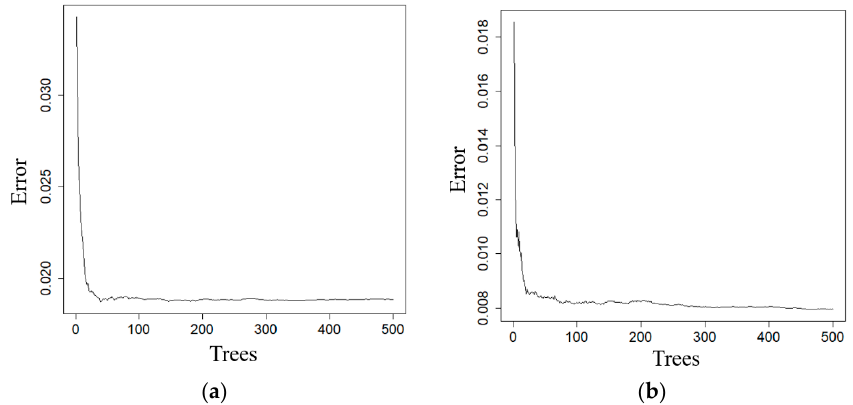
Figure 9. The error of estimates against the number of the regression trees used in random forest (RF) for ( a ) Duolun County and ( b ) Kangbao County. for ( a ) Duolun County and ( b ) Kangbao